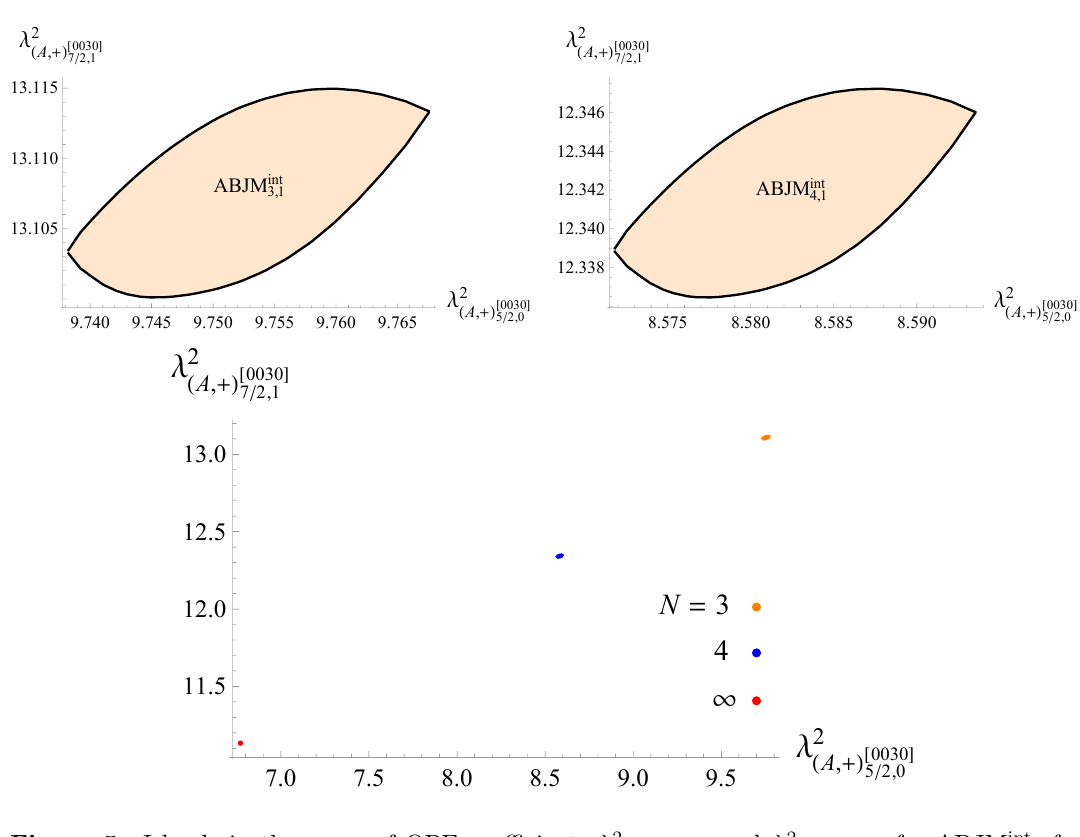
Figure 5 . Islands in the space of OPE coe(cid:14)cients (cid:21) 2 N = 3 ; 4, where the orange shaded regions are allowed. These bounds are computed using mixed correlators with (cid:3) = 35 and the short OPE coe(cid:14)cients (cid:12)xed to their values for ABJM int ABJM int using the 1d theory in section 3. The bottom plot compares these islands to the N ! 1 4 ; 1 GFFT values in table